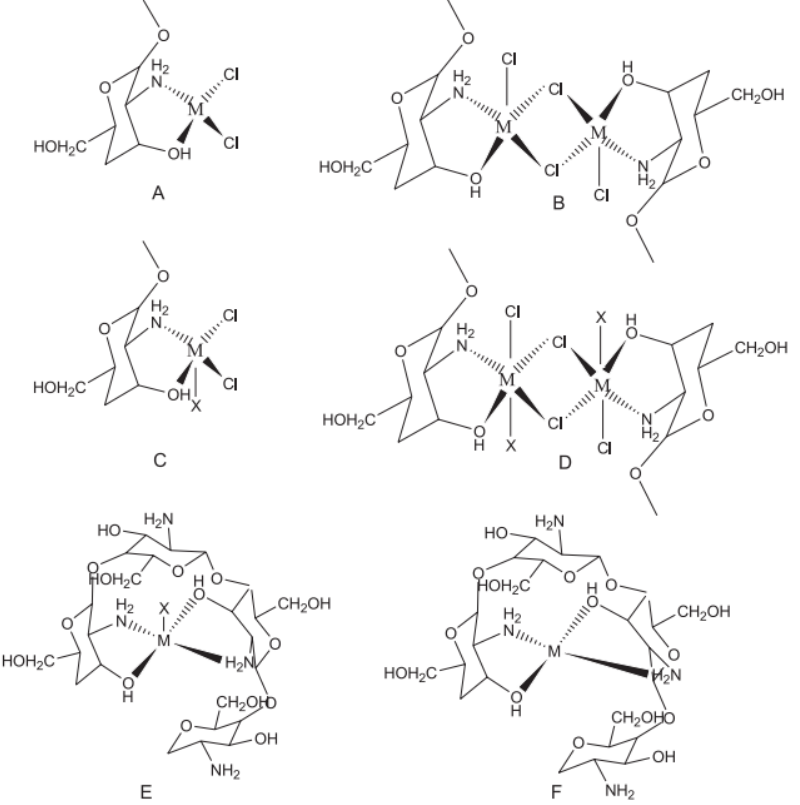
Figure 9. Chelation of metal ions by chitosan in different geometries. Figure adapted from Ref. [265]. ( A ) tetragonal ( B ) and ( C ) pentagonal ( D ) hexagonal ( E ) pentagonal ( F ) tetragonal geometries.